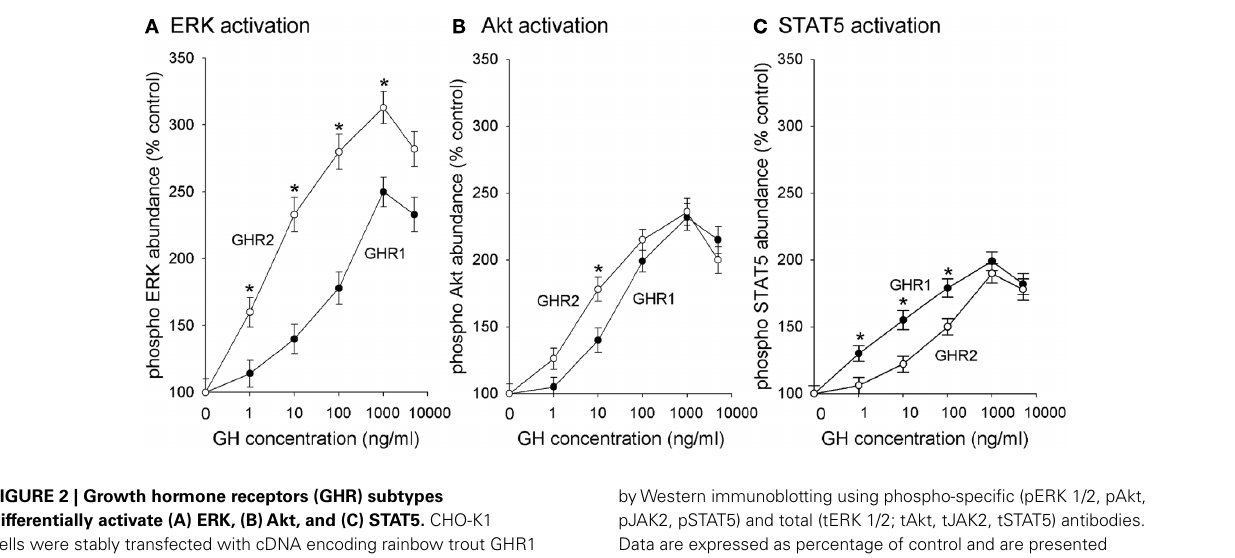
FIGURE 2 | Growth hormone receptors (GHR) subtypes differentially activate (A) ERK, (B)Akt, and (C) STAT5. CHO-K1 cells were stably transfected with cDNA encoding rainbow trout GHR1 and GHR2. Cells were incubated with various concentrations of salmonid GH for 10min (control is 0ng/ml); after which time, the cells were collected and lysed. Lysates were separated by SDS-PAGE followed